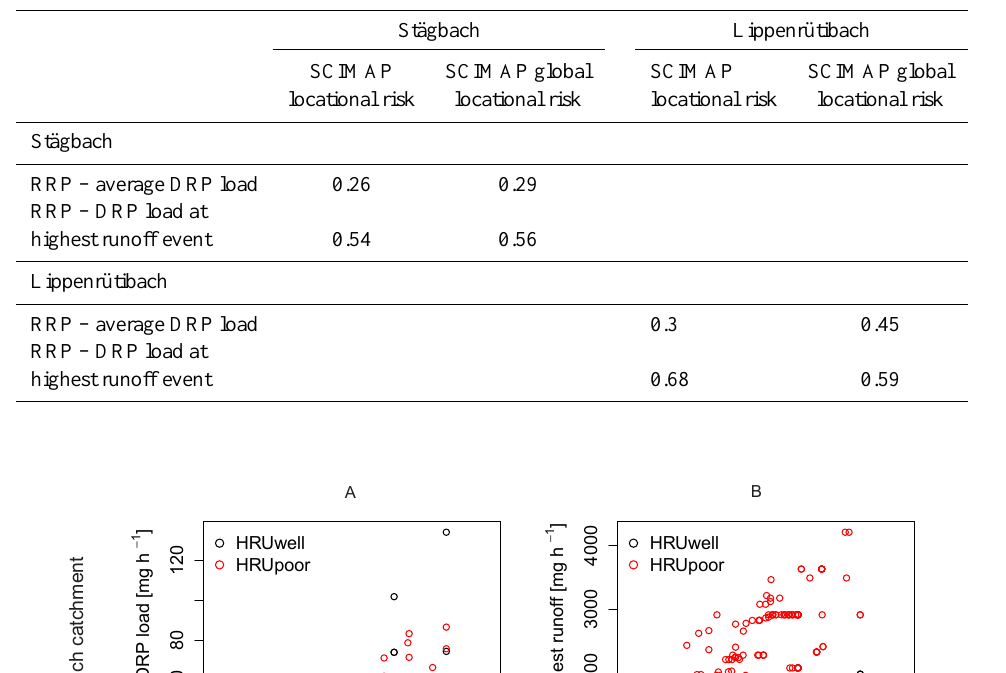
Table 5. Weighted kappa values for pair-wise comparisons of RRP and SCIMAP predictions for P loss risks in the two study catchments, showing (i) that SCIMAP risk predictions were in better agreement with RRP model predictions for the event with highest runoff than for the average DRP load over the simulation period and (ii) that average DRP load predictions obtained with RRP were in better agreement with the global than with the original catchment-specific prediction of the locational risk using SCIMAP.